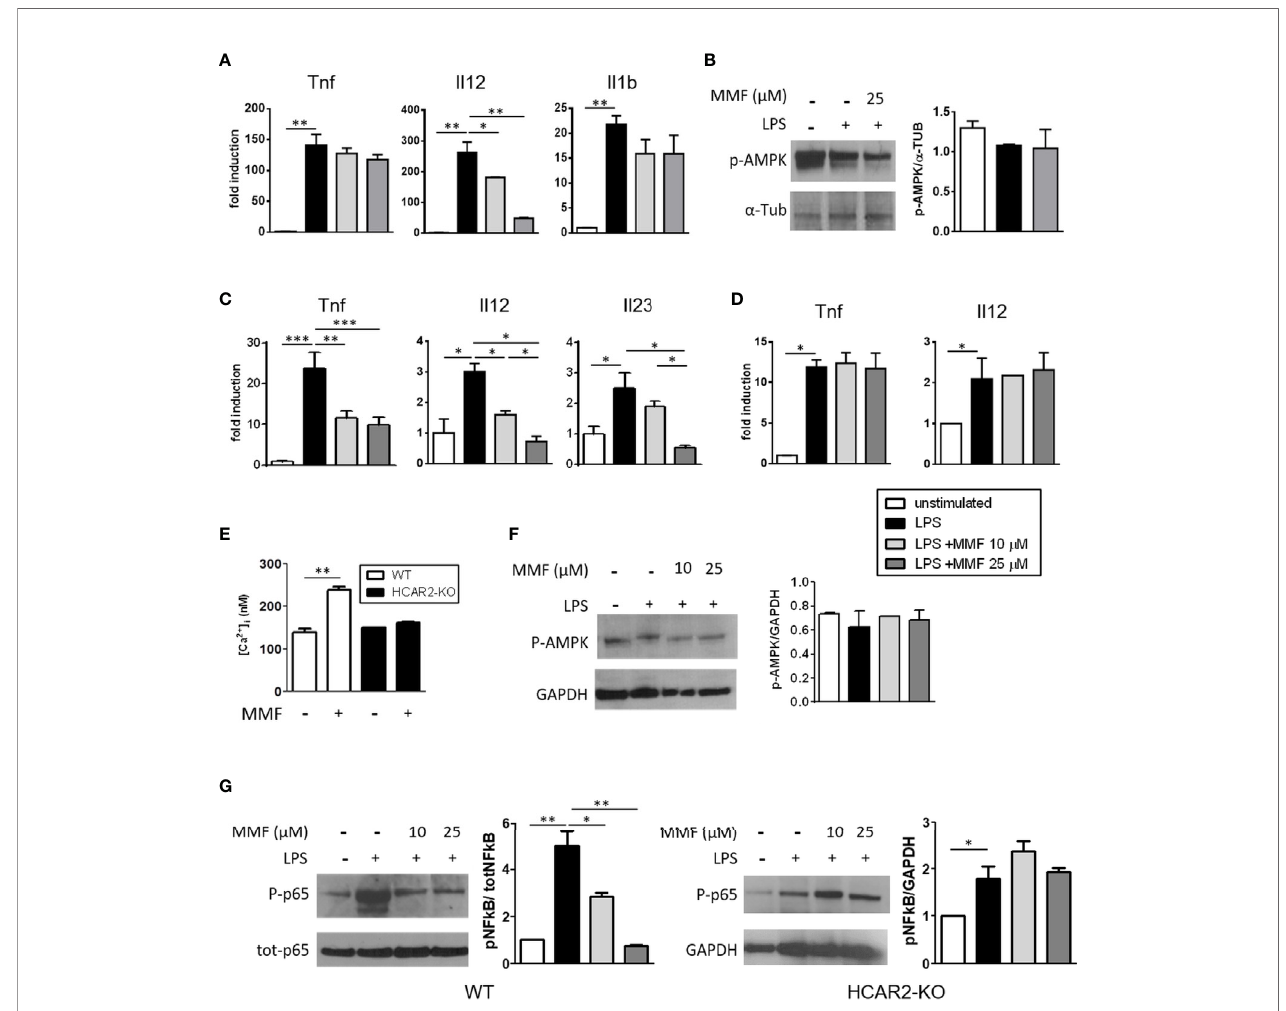
FIGURE 1 | MMF reduces sDC activation through an HCAR2-dependent inhibition of NF-kB p65 phosphorylation. (A) MMF signi fi cantly decreases Il12 expression in LPS-activated BM-DC. Tnf , Il12 , and Il1b mRNA expression in LPS-activated BM-DC treated or not with MMF for 6 h. (B) MMF does not signal through AMPK/ Sirt1 axis in activated BM-DC. Western blotting for P-AMPK in LPS-activated BM-DC treated or not with MMF for 30 min. Representative blot (left panel) and densitometric quanti fi cation of replicate experiments (right panel). (C) Treatment with MMF reduces the pro-in fl ammatory cytokine pro fi le of LPS-activated sDC. Tnf , Il12 , and Il23 mRNA expression in LPS-activated sDC treated or not with MMF for 6 h. (D) The anti-in fl ammatory effect of MMF on sDC is dependent on HCAR2. Tnf and Il12 mRNA expression in LPS-activated sDC isolated from HCAR2-KO mice, in presence or absence of MMF for 6 h. (E) MMF induces HCAR2-dependent increase in [Ca2+]i in sDC. [Ca2+]i measured by Fura 2AM analysis in sDC from WT and HCAR2-KO mice treated or not with MMF (25 m M) for 1 h. (F) MMF signaling through HCAR2 in LPS-activated sDC does not involve AMPK/Sirt1 axis. Western blotting for P-AMPK in LPS-activated sDC treated or not with MMF for 30 min. Representative blot and densitometric quanti fi cation of replicate experiments are shown (left and right panels, respectively). (G) MMF signaling through HCAR2 in LPS-activated sDC inhibits NF-kB phosphorylation. Western blotting for P-p65 and tot-p65 in LPS-activated sDC from WT (left panel) and HCAR2-KO (right panel) mice treated or not with MMF for 30 min. Representative blots and densitometric quanti fi cation of replicate experiments are shown. Real time PCR data are presented as fold induction of gene expression in treated cells over untreated cells. Quanti fi cation of Western blotting by densitometric analysis of bands is presented as P-AMPK over a -Tub (B) or P-p65 over tot-p65, normalized to GAPDH (F) . a -Tub (B) or GAPDH (F, G) were assessed as loading controls. Results are shown as mean ± SEM of at least N = 3 experiments. * P < 0.05, ** P < 0.01, and *** P <